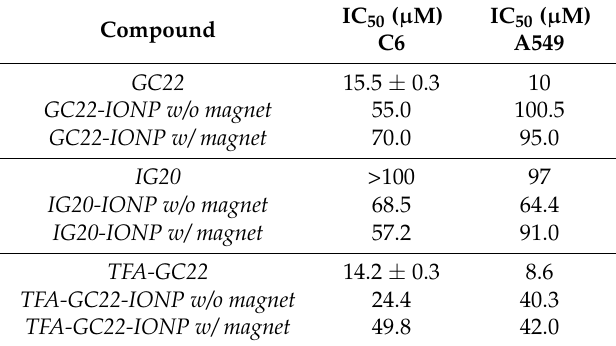
Table 1. Comparison of the IC 50 of the free glycosides and the glycosides-coated IONP micelles. w/o: without magnet; w/: with magnet.